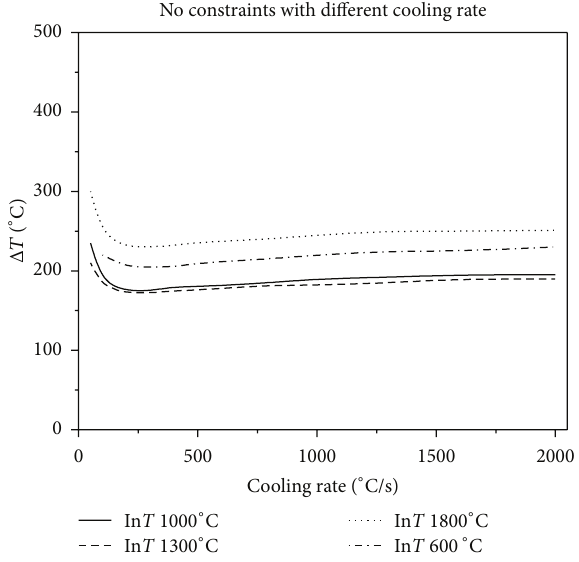
Figure 2: Relationship between critical fracture temperature Δ𝑇 corresponding to different thermal shock initial temperature (in the figure is InT, the same as follows) and cooling rate without constraints.